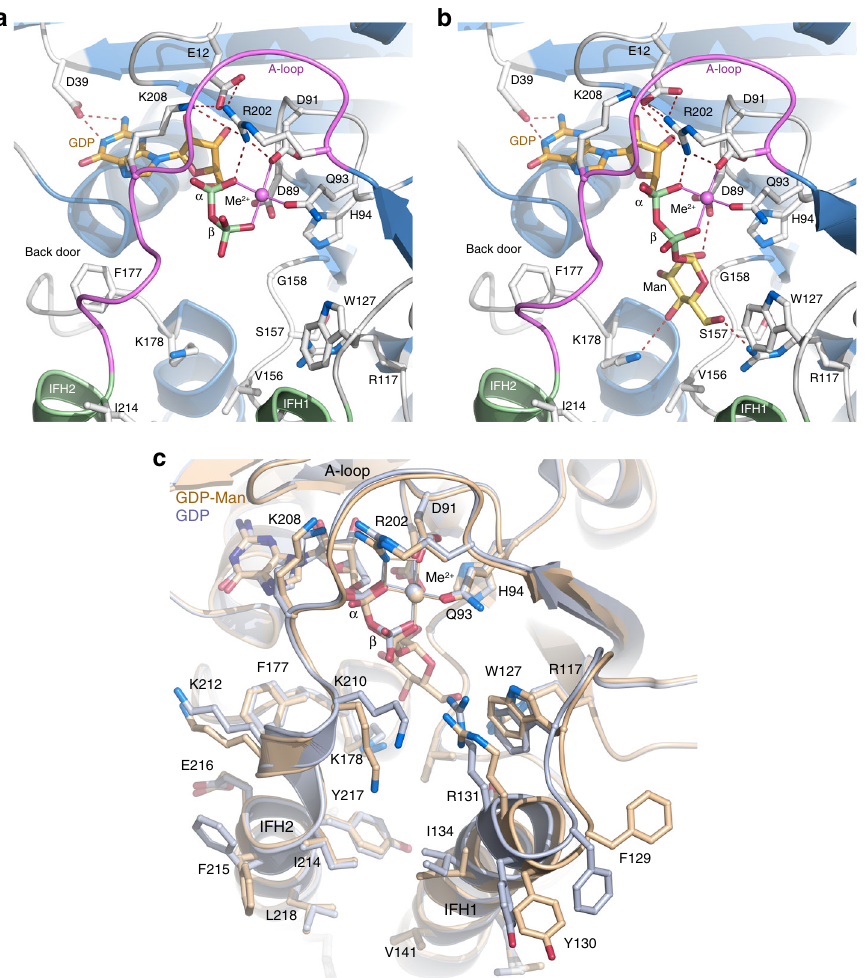
Fig. 2 Details of nucleotide and donor binding. a The Pf DPMS active site with bound GDP • Mg 2+ and b GDP-Man • Mn 2+ in the absence of acceptor substrate. The acceptor loop ( purple ) is locked in a closed conformation by ionic bonds between Glu12 and Arg202 and Lys208 close to the GDP α -phosphate. The IF helices do not participate directly in donor binding. Asp39 interacts with the N1 and N2 atoms of the guanine base, and Phe177 acts as a gate and closes off the pocket exit. c Superimposition of the Pf DPMS • GDP • Mg 2+ ( beige ) and Pf DPMS • GDP-Man • Mn 2+ ( light blue )